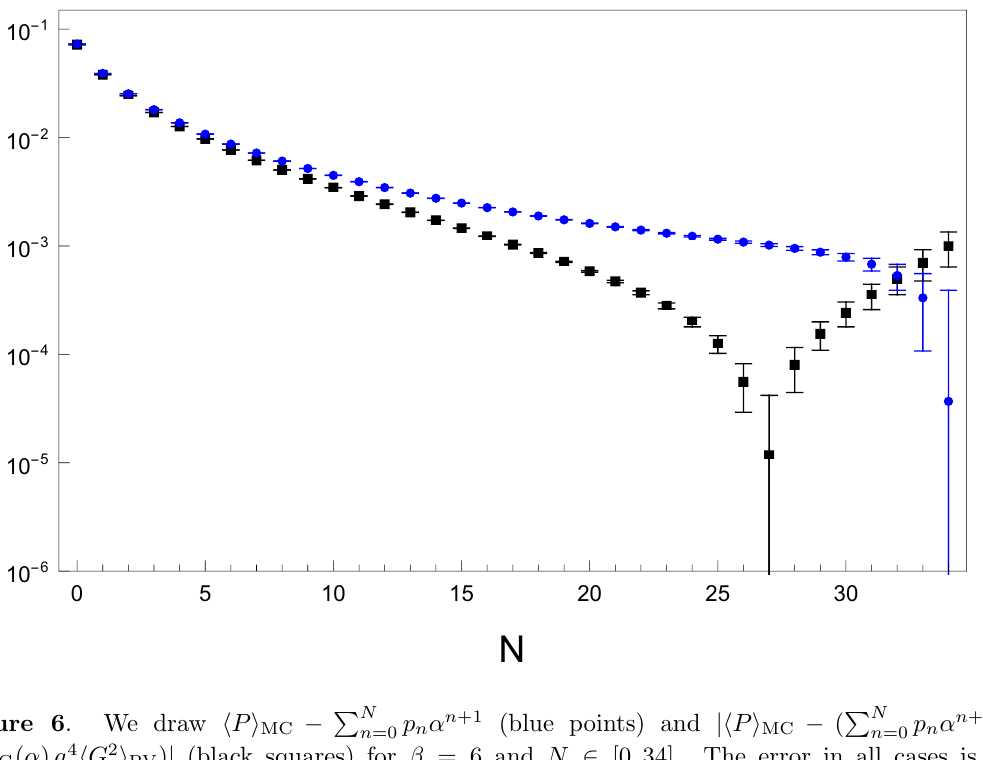
p n (cid:11) n +1 + n =0